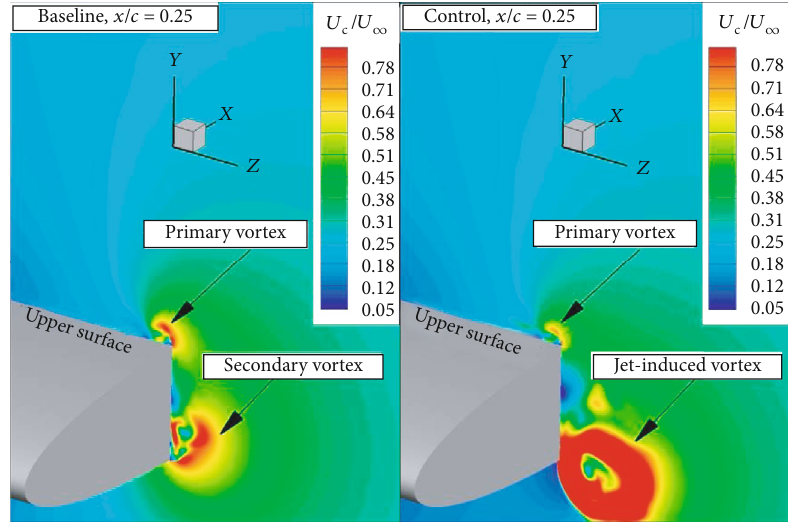
Figure 16: The lateral fl ow near the wingtip before and after normal blowing.